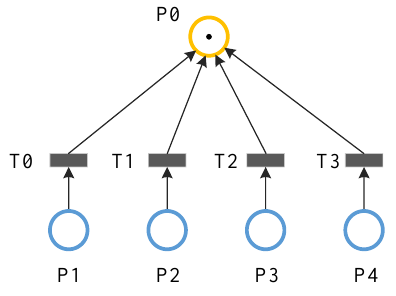
Figure 10. Running Figure 10. Running results. Figure 10. Running results.